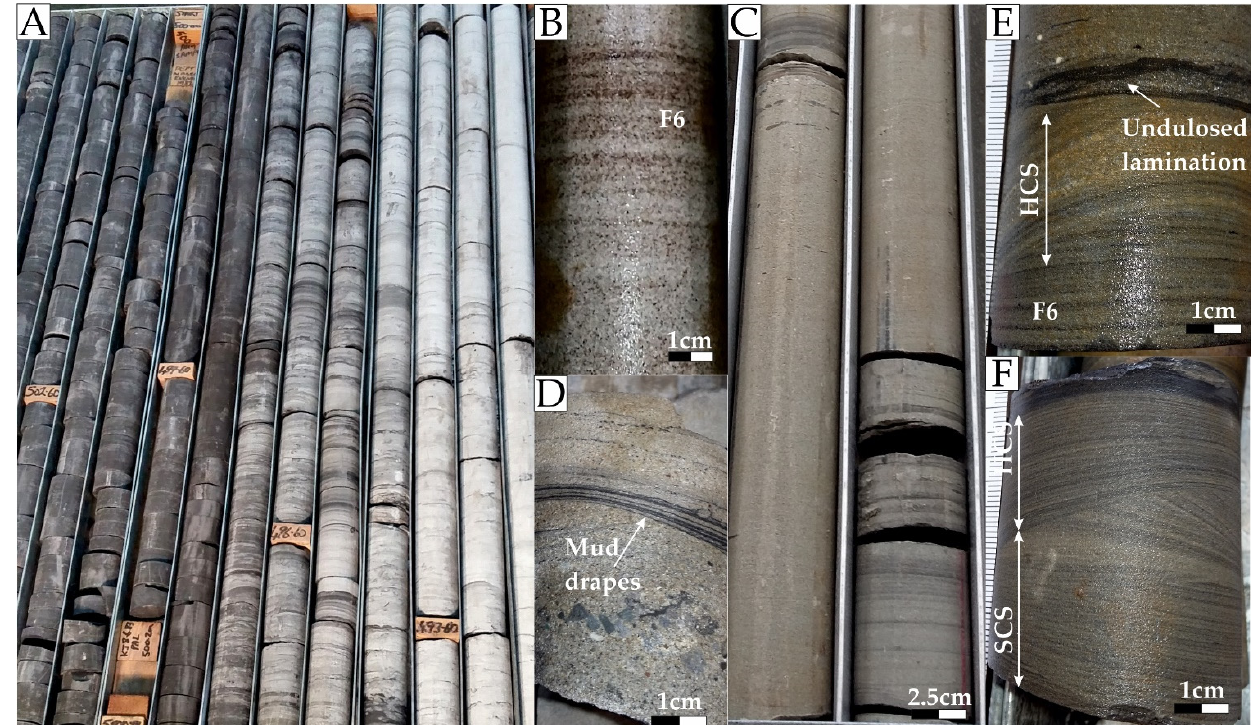
Figure 7. Core photographs illustrating sedimentological characteristics of the FA6 (delta-front). ( A ) Delta-front deposits (sand-dominated) that overlay mud-dominated deposits of the prodelta. ( B , C ) Structureless and parallel-laminated sandstone. ( D ) Mud and double mud drapes within FA6 that represent the depositional products of tidal currents. ( E ) HCS-sandstone with undulose lamination that is underlain by parallel-laminated unit. ( F ) SCS-sandstone that is overlain by HCS-sandstone.